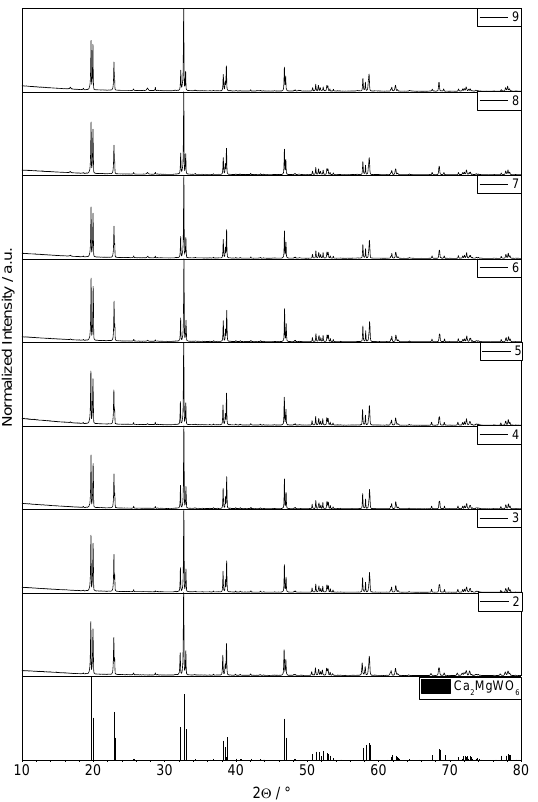
Figure 1. Room temperature X-ray diffractions (XRDs) of Cr 3+ and Nd 3+ co-doped Ca 2 MgWO 6 samples compared to the reference from the Pearson’s Crystal Database (ICDD: 04 -012-4403).